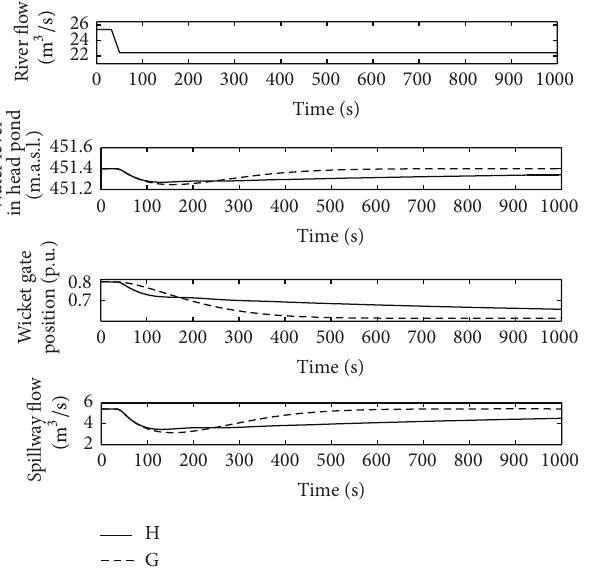
Figure 16: River flow, wicket gates position, water level in the head pond, and spillway flow, points G and H in flood